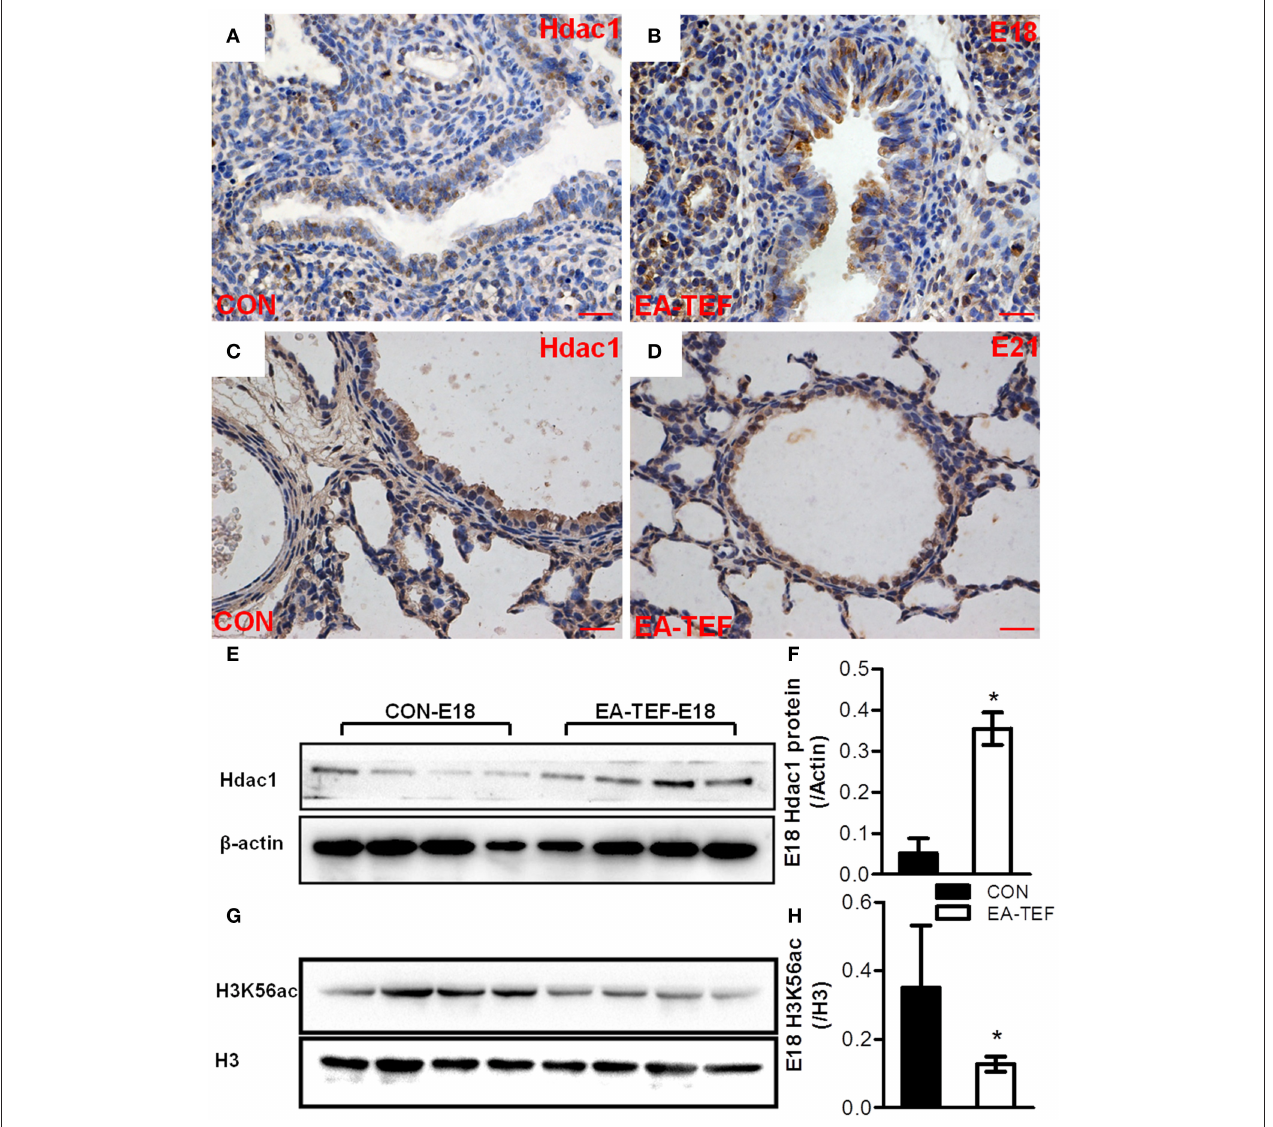
FIGURE 7 | Hdac1 protein expression and localization in fetal lungs. (A–D) Representative photomicrographs of IHC staining for Hdac1 in lung tissue sections from Control (A,C) and EA-TEF (B,D) embryos of E18 (upper panel) and E21 (lower panel). Hdac1 staining is seen throughout the mesenchyme and the luminal airway epithelium. (Original magnification × 400, scale bar = 100 µ m). There were no significant differences of protein localization. Epithelial and mesenchymal immunoreactivity for Hdac1 was stronger in EA-TEF lungs than in the control group at the canalicular stage (E18). (E–H) Representative immunoblotting and densitometric analysis of Hdac1 (E,F) and H3K56ac (G,H) protein in fetal lungs at E18. Results were normalized against expression of β -actin or total H3 respectively. * P < 0.05, vs. age-matched controls.